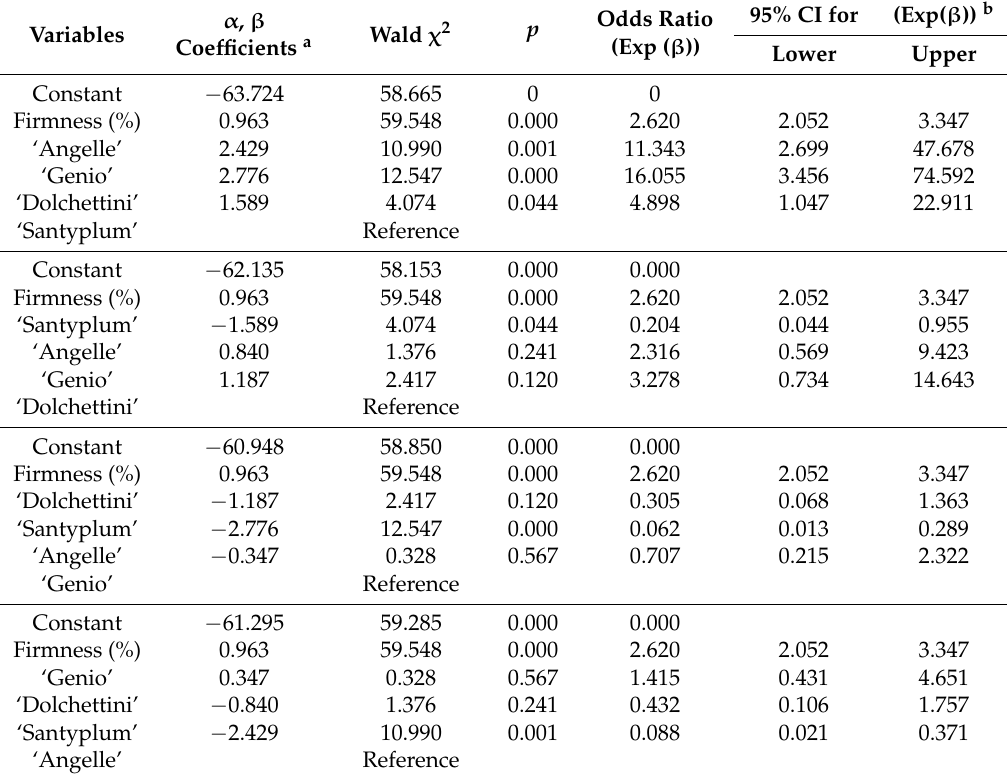
Table 2. Estimates of logistic regression parameters for cultivars and fruit firmness as influencing factors on the marketability